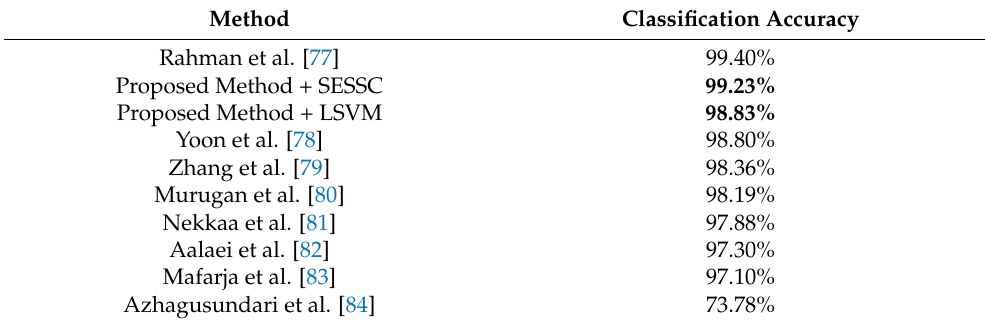
Table 8. The WDBC dataset comparison results of the proposed method with other methods. The results are sorted in descending order. Bolded values are the results obtained from this study.